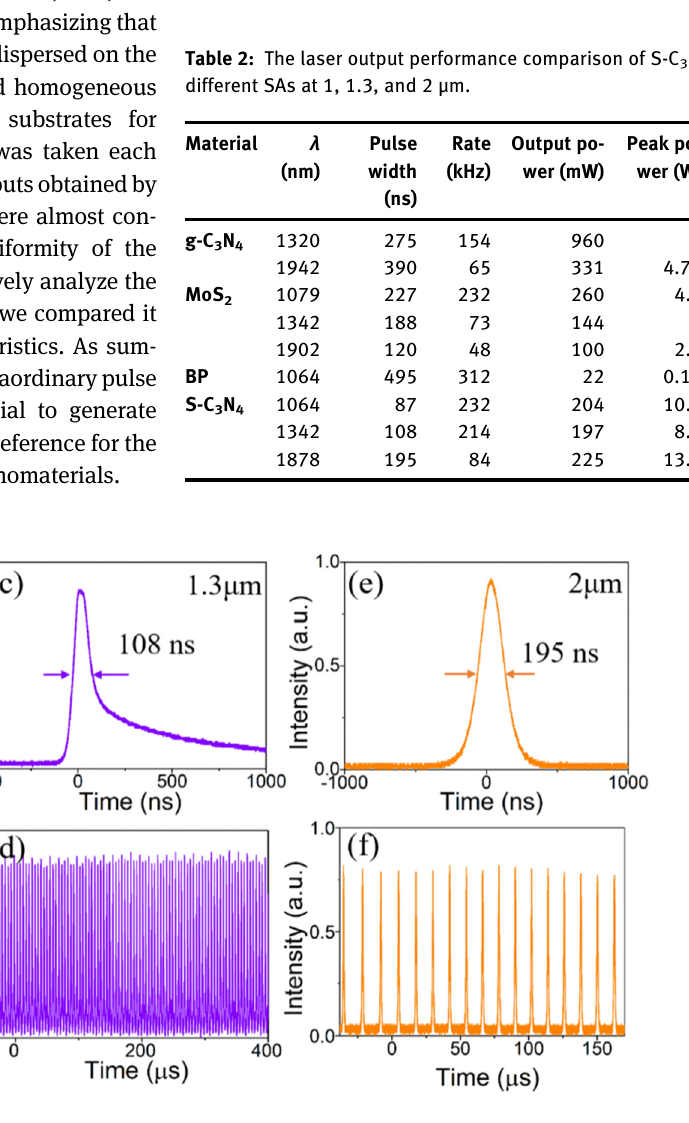
Figure 4: Experimental performances of the PQS lasers with CuO and TiO 2 /CuO nanocomposites at 1.06 μ m. (a) CW and Q-switched average outputpower.(b)Pulsewidthandrepetitionrate versustheincidentpumppower.(c),(d)TypicalQ-switchedtemporalpulsepro fi leandtrains of CuO and TiO 2 /CuO lasers, respectively.